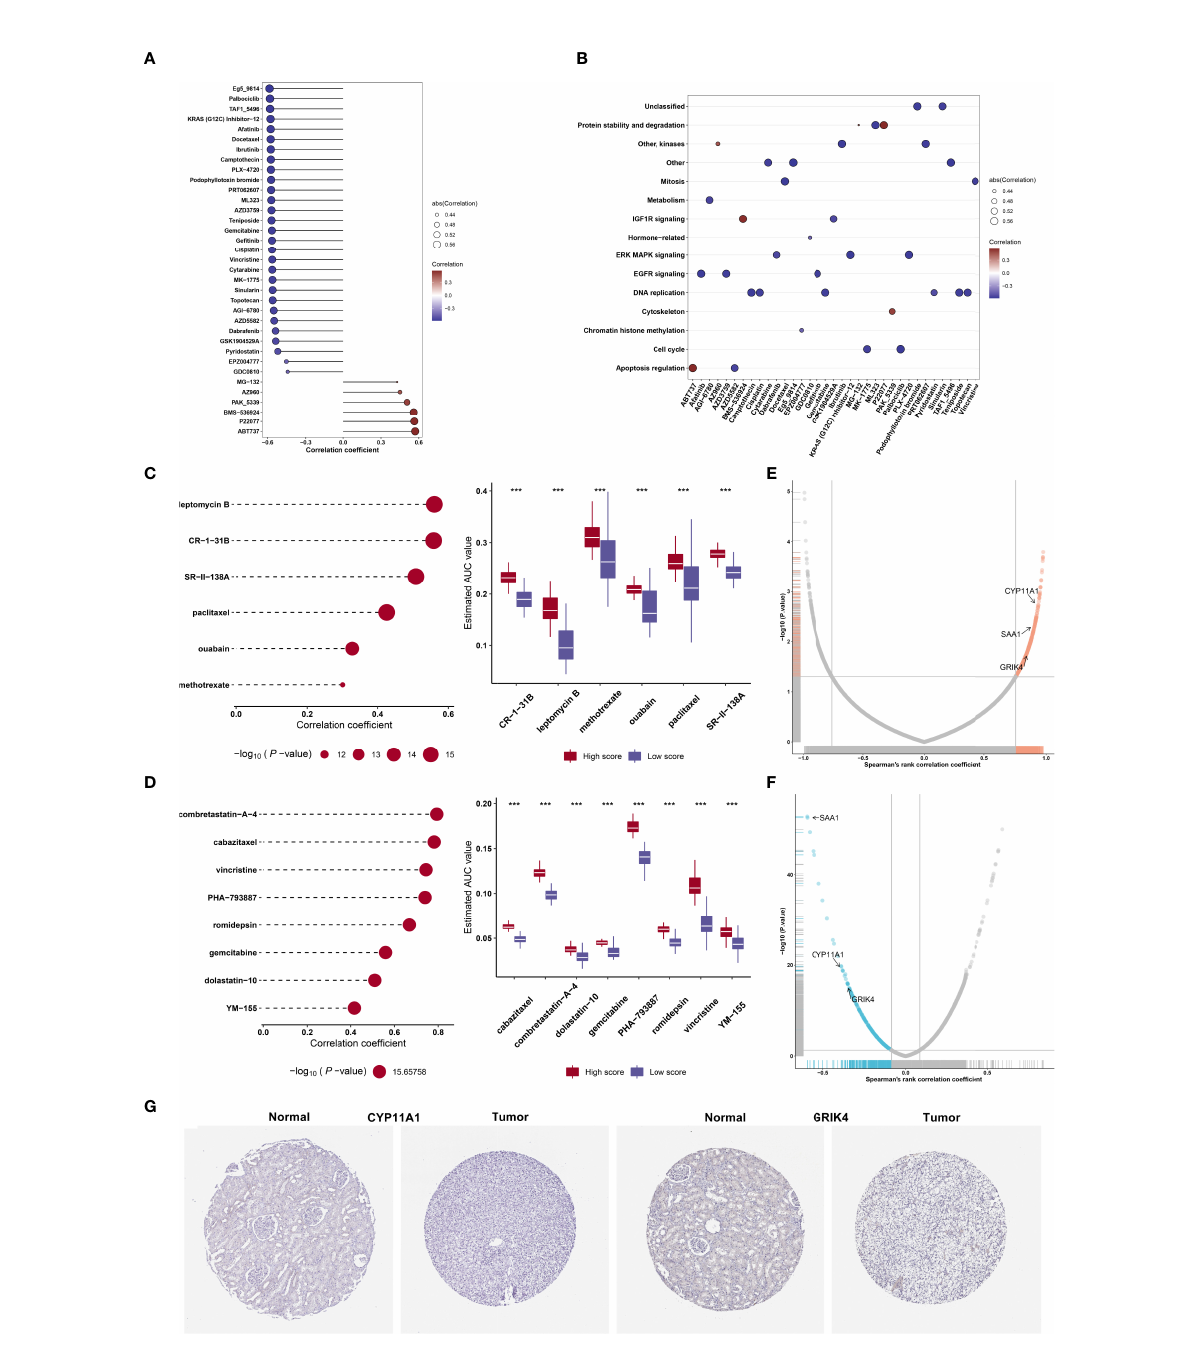
FIGURE 8 Identi fi cation of agingScore-related candidate compounds and drug targets. (A) Spearman ’ s correlation analysis of GDSC-derived compounds and agingScore. (B) Mechanisms involving GDSC-derived compounds. (C) Spearman ’ s correlation analysis of six CTRP-derived compounds and agingScore as well as differential analysis of drug responses between the high and low agingScore groups. (D) Spearman ’ s correlation analysis of eight PRISM-derived compounds and agingScore as well as differential analysis of drug responses between groups. A lower AUC value implies higher drug sensitivity. *** P < 0.001. (E) Volcano plot of Spearman ’ s correlation between agingScore and CERES score of drug targets. The red dot represents the signi fi cantly positive correlation ( P < 0.05, and Spearman ’ s correlation coef fi cient>0.82). (F) Volcano plot of Spearman ’ s correlation between agingScore and protein expression of drug targets. The blue dot indicates a signi fi cant negative correlation ( P < 0.05, and Spearman ’ s correlation coef fi cient ≤ 0.1). (G) Immunohistochemistry of the expression of CYP11A1 and GRIK4 in normal and kidney cancer tissues. Bar, 200 m